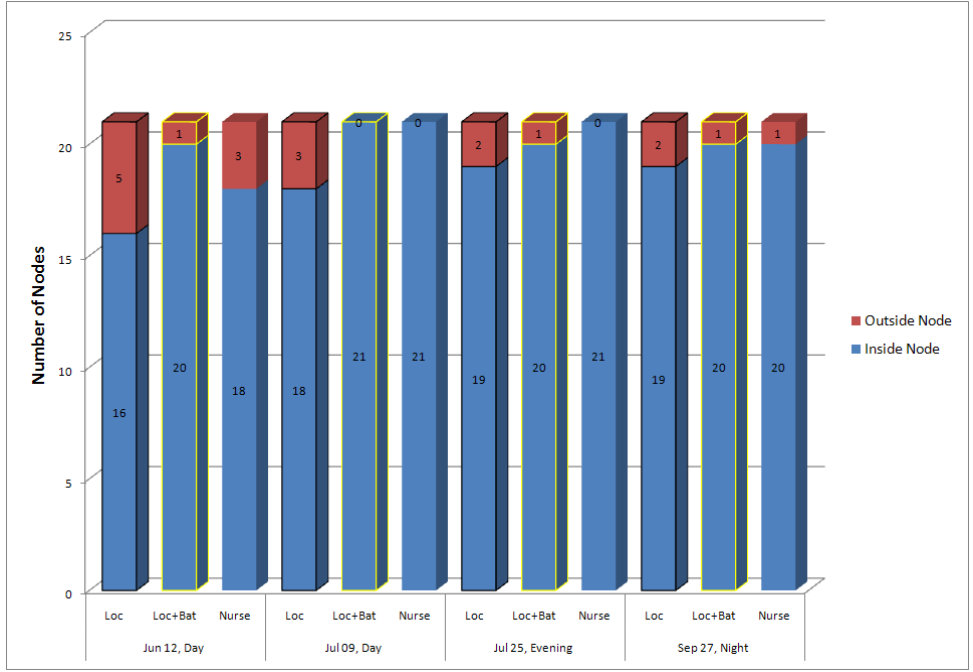
Figure 12. Failure detection of outside